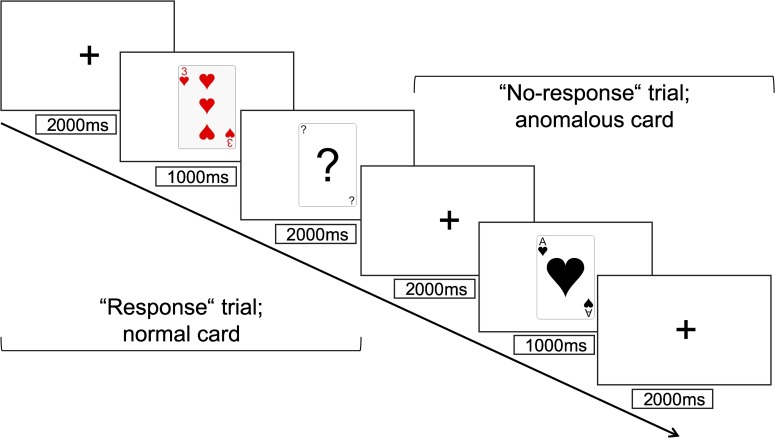
Time course of trials with and without response.